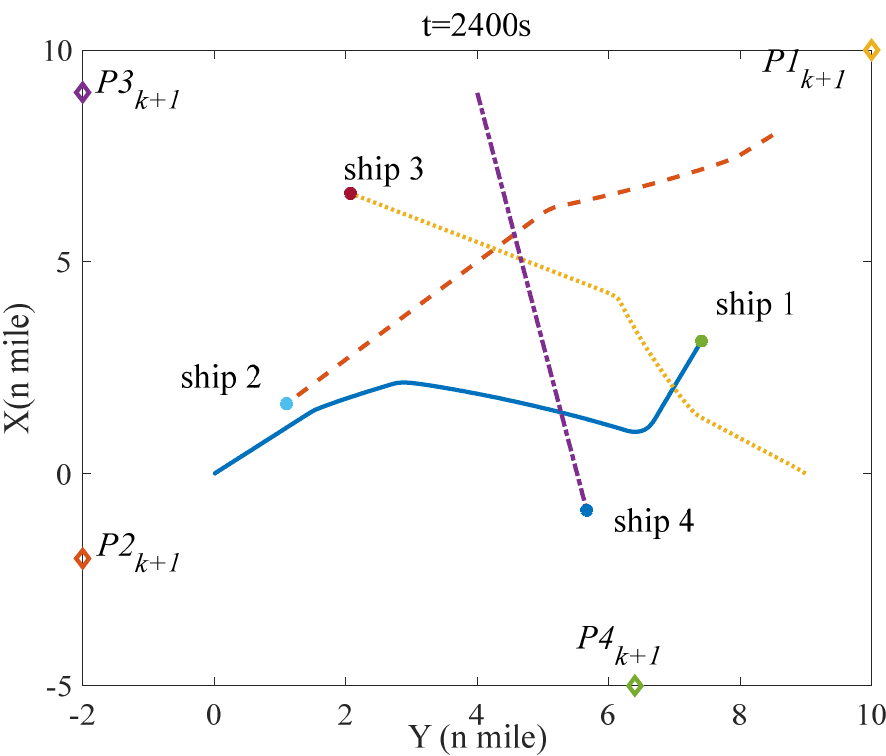
Figure 14. The situation of four ships at t = 1200 s in scenario 2.